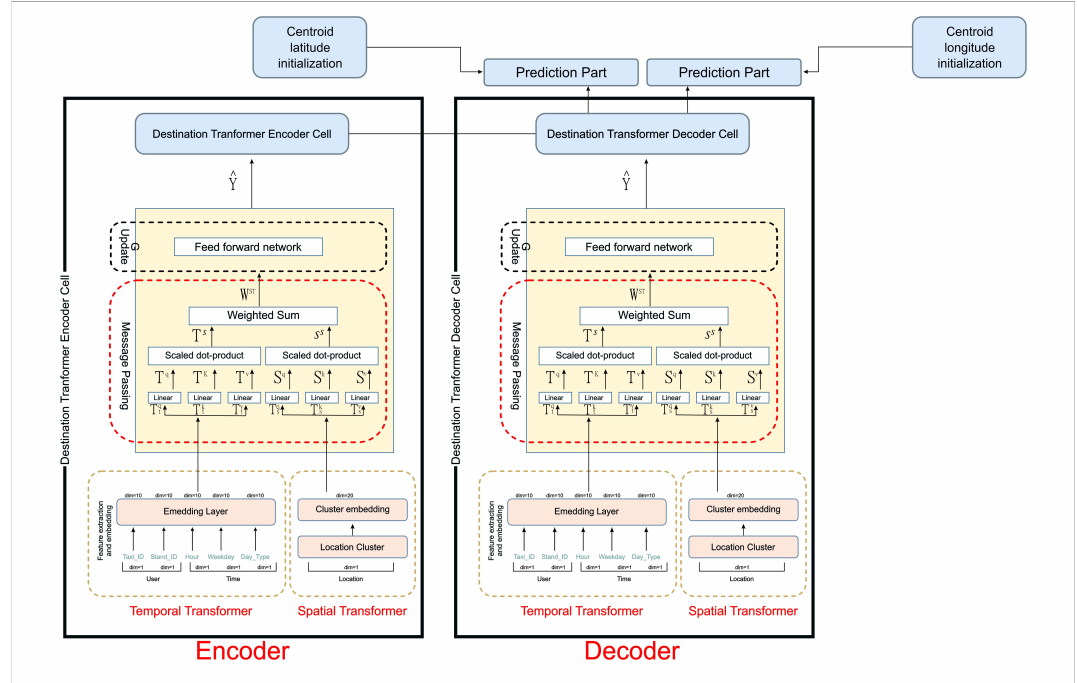
Figure 2. Main framework: ( Left ) the encoder part; and ( Right ) the decoder